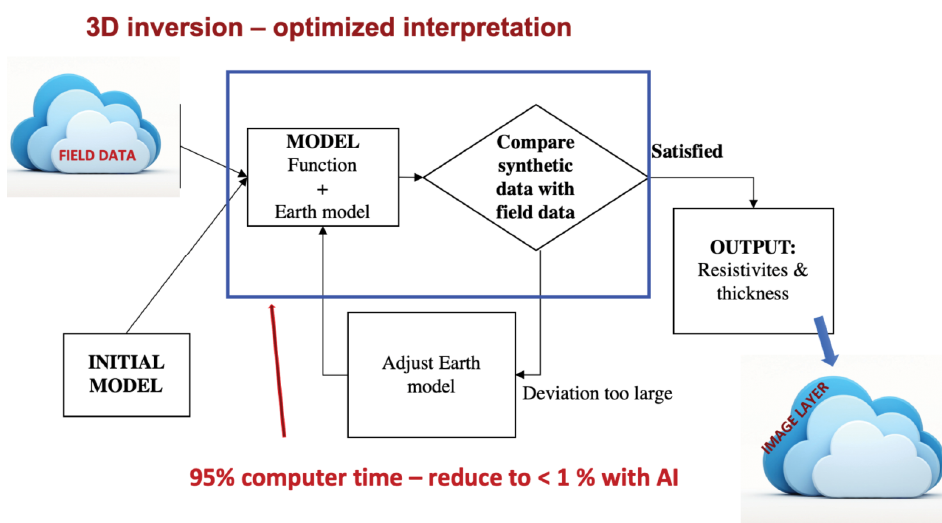
Figure 11. Inversion flow diagram dissecting the forward modeling from the model adjustments and Cloud interaction. The input comes from the DATA layer and the out goes to the IMAGE layer of the Cloud.